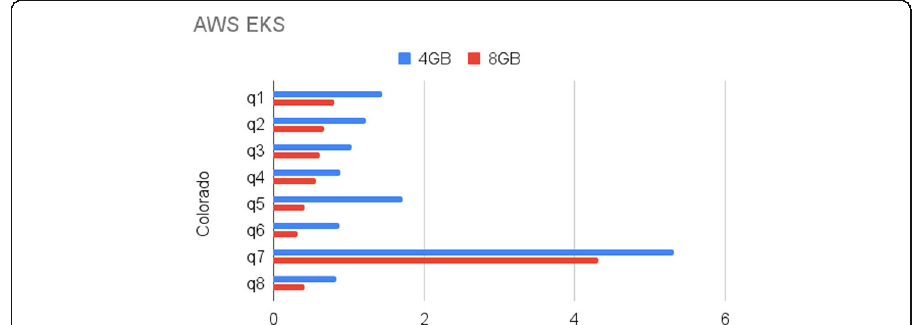
Fig. 13 AET for all benchmarking queries in AWS EKS for Colorado State